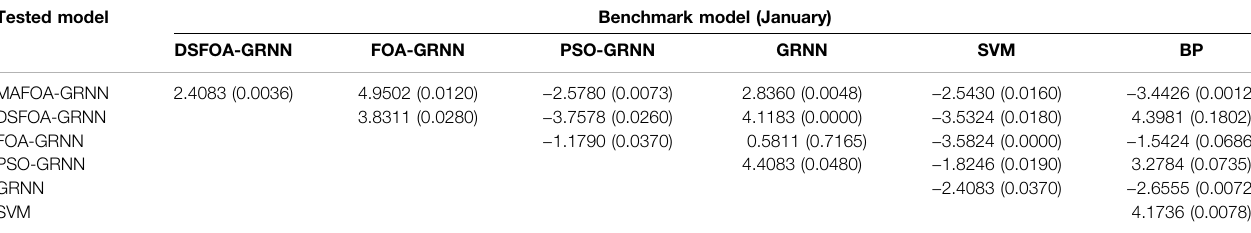
TABLE 6 | DM results of the different models.